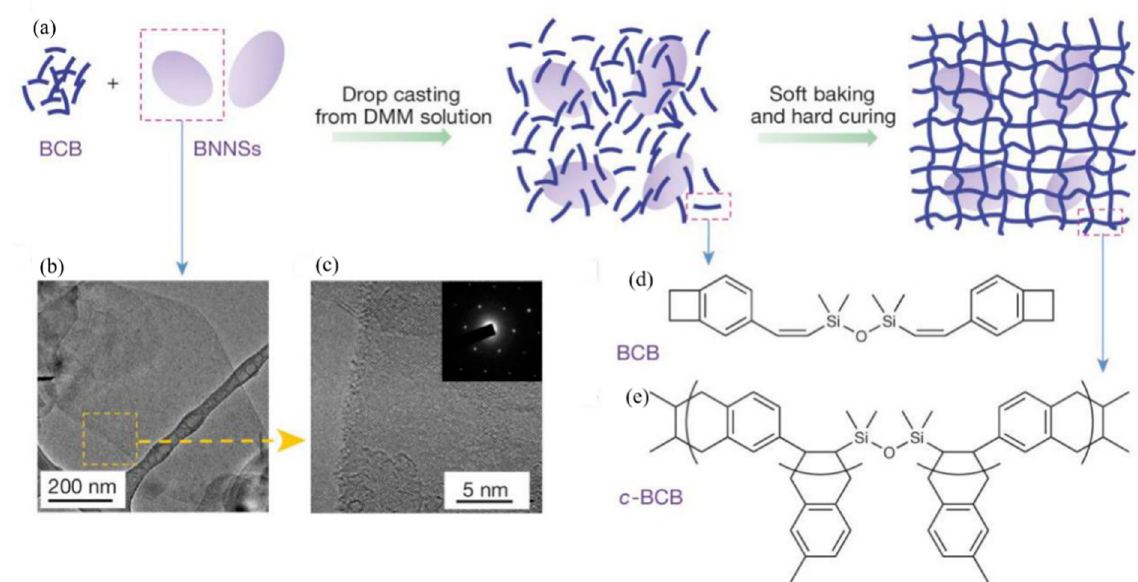
Figure 3. Material preparation and structures. ( a ) Schematic of the preparation of c-BCB/BNNS films. ( b , c ) Transmission electron microscopy (TEM) images of BNNSs exfoliated from h-BN powders. Inset of c is an electron-diffraction pattern of BNNSs, showing its hexagonal symmetry. ( d ) Chemical structure of the BCB monomer. ( e ) The repeating unit of c-BCB. Reprinted with permission from [12]. Copyright 2015, Springer Nature.